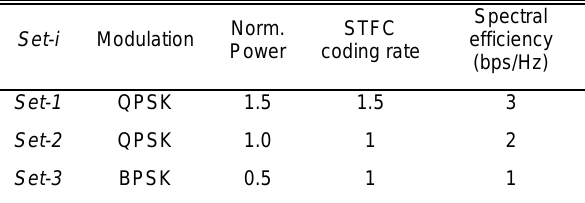
Table 1. Parameters of the adaptive